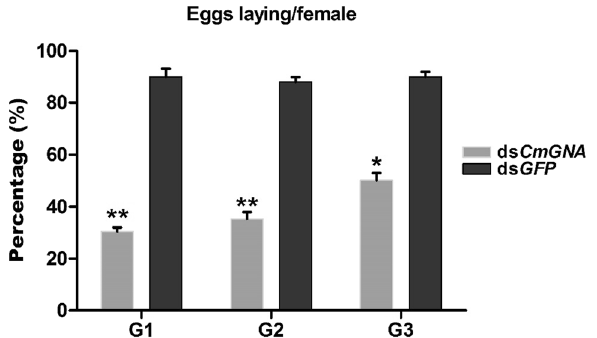
Figure 1. The percentage laid eggs per female in G1–G3 generations. Each point indicates the mean ± standard error in G1–G3 generations along with their control groups. Significant differences indicated by *(P < 0.05), **(P < 0.01).